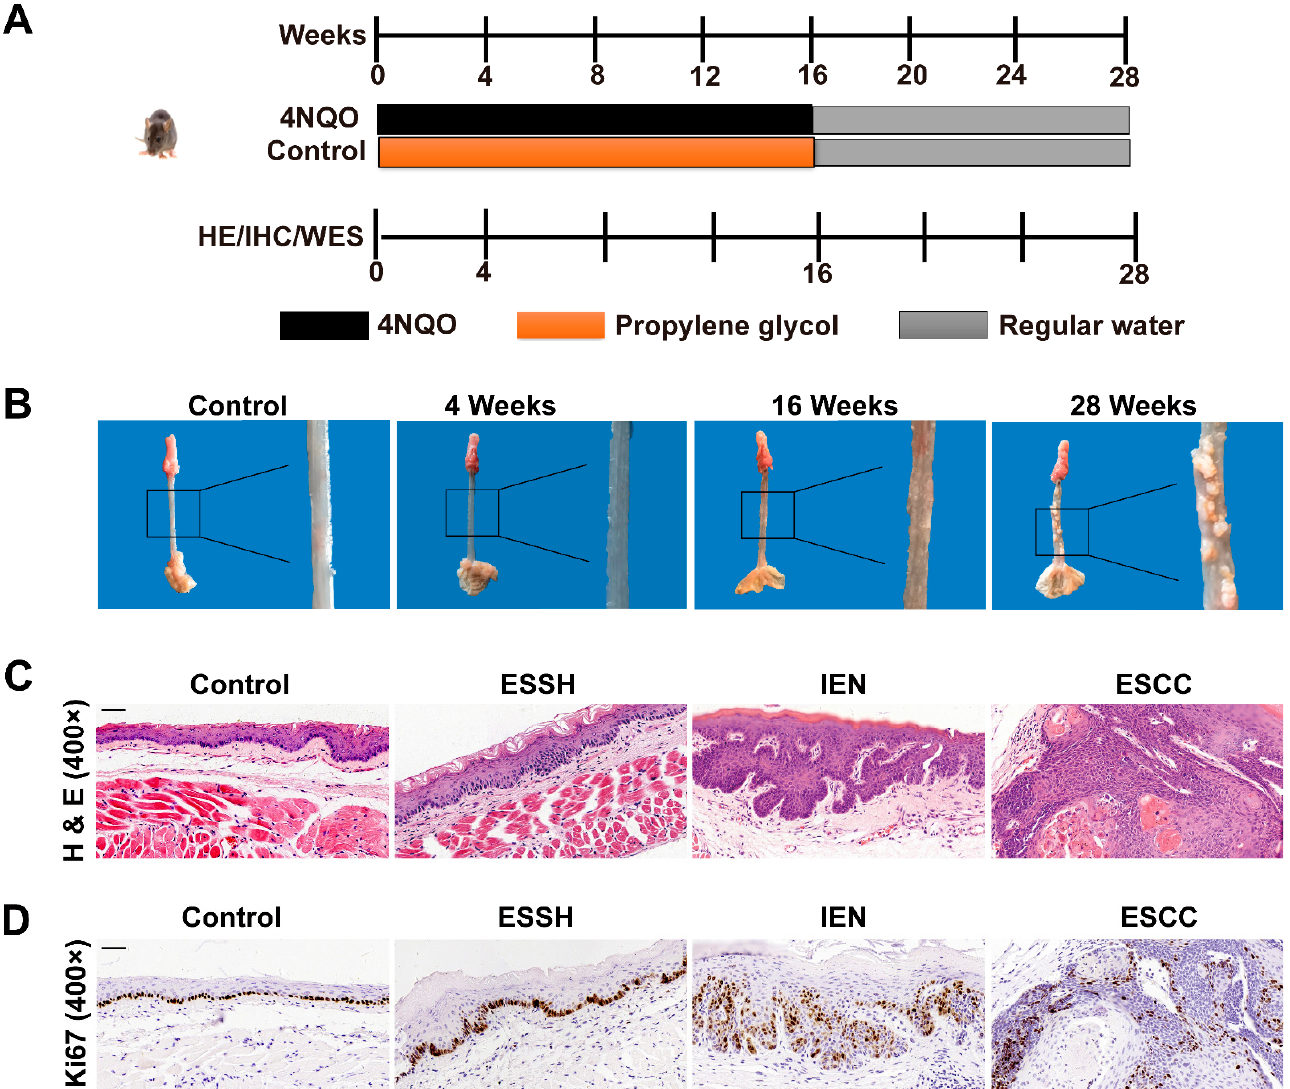
Figure 1. 4NQO-induced neoplastic changes in esophagus tissues of mice at different time intervals. Control, normal; ESSH, simple hyperplasia; IEN, intraepithelial neoplasia; ESCC, esophageal squa- mous cell carcinoma. ( A ) Scheme for the treatment paradigm. C57BL/6 mice were randomized into two groups and fed with water or 4NQO (100 µ g/mL) in drinking water for 16 weeks, after which all mice were given deionized water until week 28. Mice were sacrificed at different time points of 4NQO treatment at 0, 4, 8, 12, 16, 20, and 28 weeks to observe the different pathological stages of carcinogenesis in mice. The histopathological assessment, immunohistochemistry, and WES of esophageal tissues were performed after 4, 16, and 28 weeks. ( B ) Representative images of esophageal lesions for each stage. ( C , D ) Histological analysis and ki-67 staining of mice’s normal esophagus and ESCC esophagus for each stage. (Magnification, × 400; scale bar = 50 µ